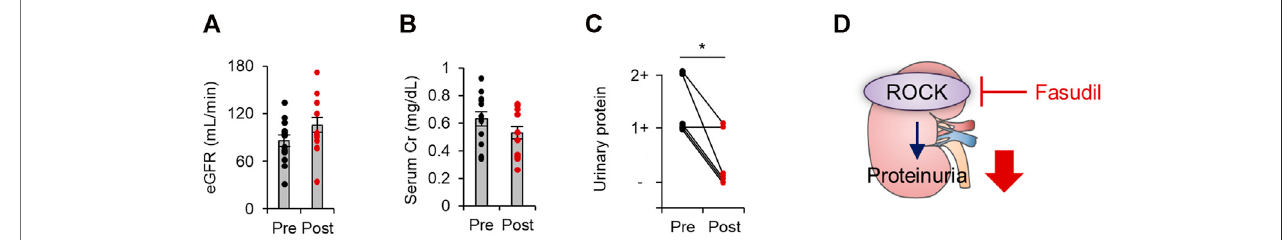
FIGURE 3 | The renal outcomes in patients with diabetes treated with fasudil. (A) The estimated glomerular fi ltration rate (eGFR) before and after treatment with fasudil ( n (cid:1) 15). (B) Serum Cr levels before and after treatment with fasudil ( n (cid:1) 11). (C) The urinary protein levels evaluated by a dipstick test before and after treatment with fasudil ( n (cid:1) 6) * p < 0.05. Data represent the mean ± s.e.m. Cr, creatinine. (D) A schematic summary of key observations. In patients with diabetes, renal ROCK activity is elevated. Fasudil attenuates ROCK activity and